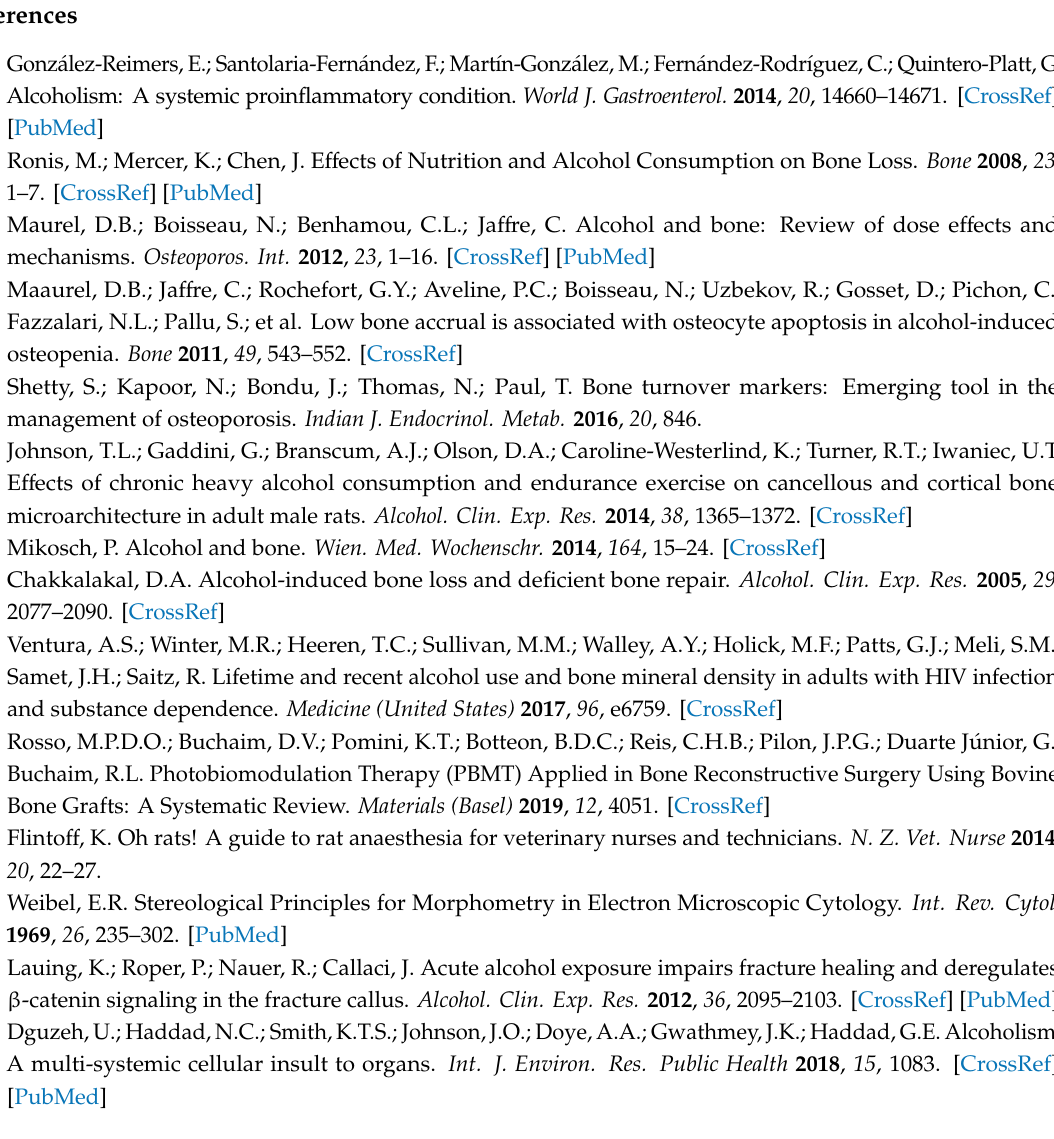
Figure S1: Representative image of the methodology used to quantify the area of newly formed bone, graft particles, by Axio Vision